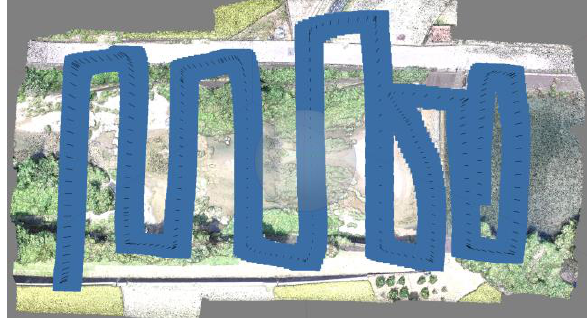
Figure 6. Point cloud data and camera